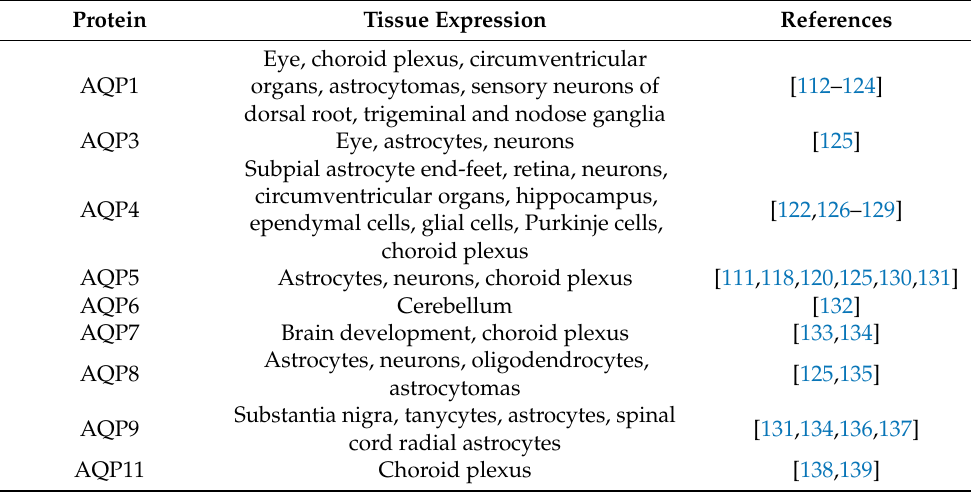
Table 1. Distribution of aquaporins in brain’s tissues. Modified from Trillo et al., 2022 [111]. Protein Tissue